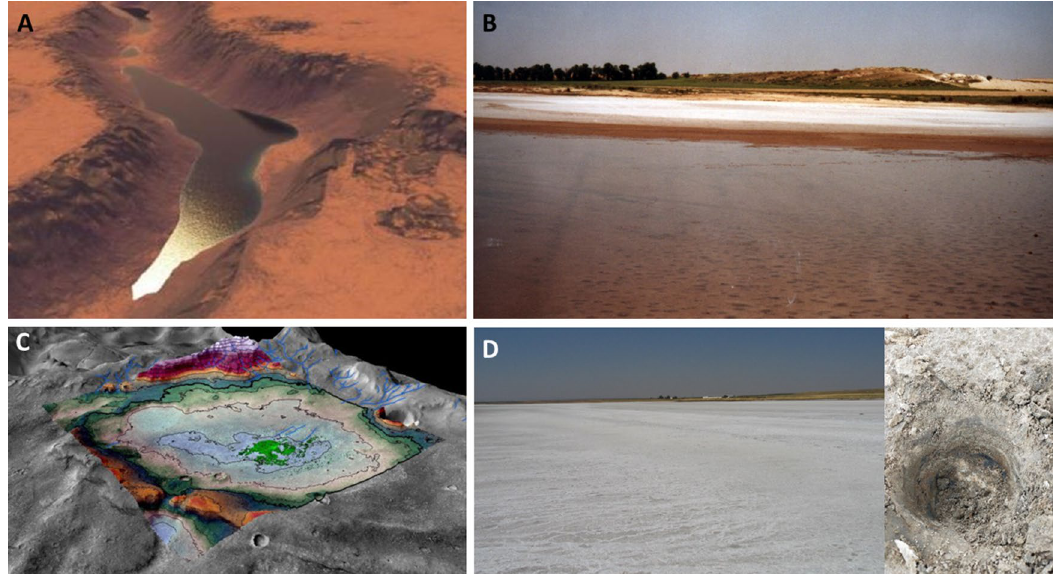
Figure 1. ( A ) Artistic impression showing ancient lakes ponded on Mars (credit: G. Di Achille, University of Colorado); ( B ) photograph of Tirez taken in 2002, when the lake was still active; ( C ) detection of evaporite salts in shallow basins in Meridiani (for interpretation, see Ref. 3 ); ( D ) dry Tirez as it looks today, showing the evaporite salts, and an inset detailing the drilled sediments for this study.